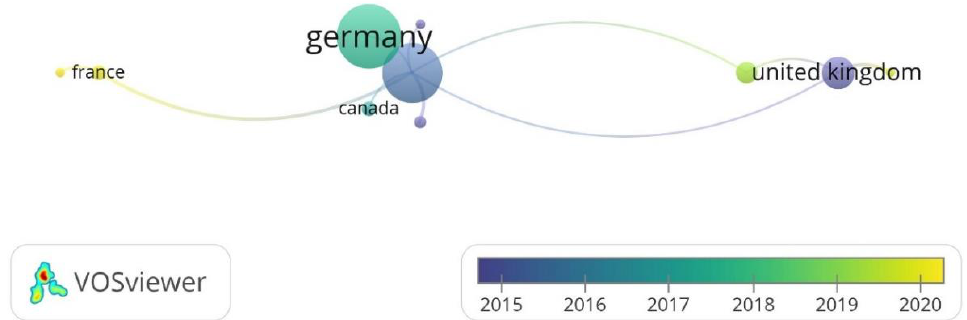
Figure 2. Network of countries based on co-authorship.